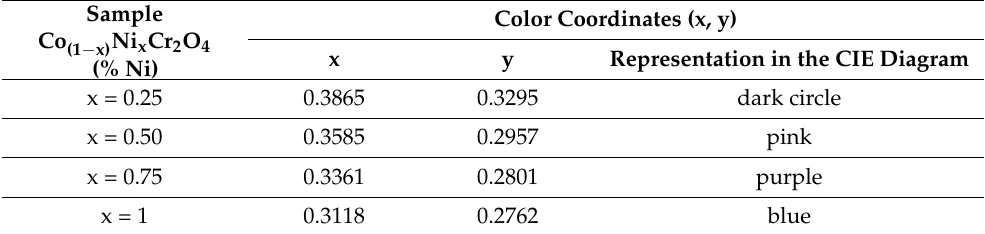
Figure 8. Chromaticity diagram. The place of the pigment nanopowders. Table 3. Calculated values of the pigment nanopowder color.